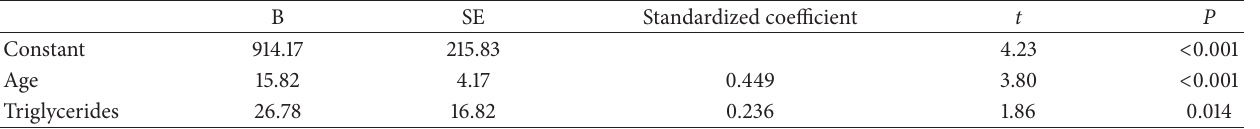
Table 5: Multiple linear regression analysis of factors associated with